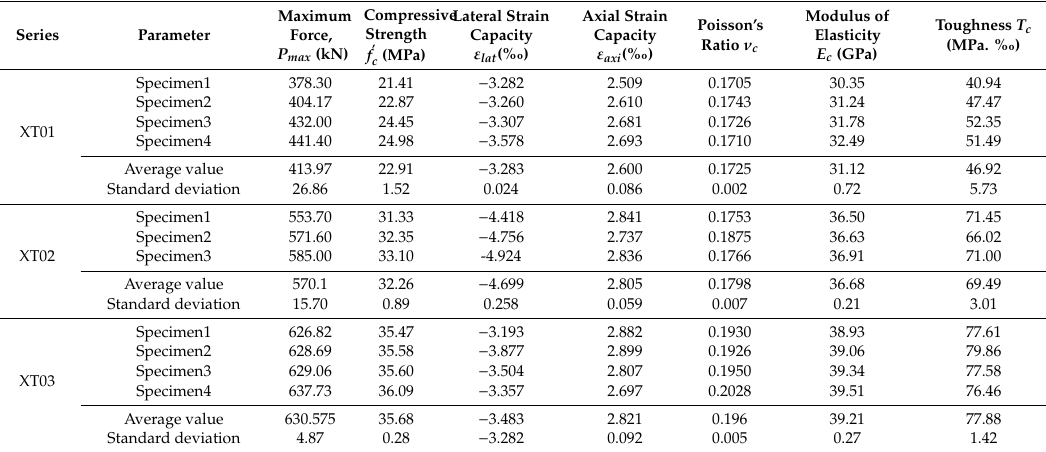
Table 6. Compressive parameters of the steel-slag concretes at 28-day age.